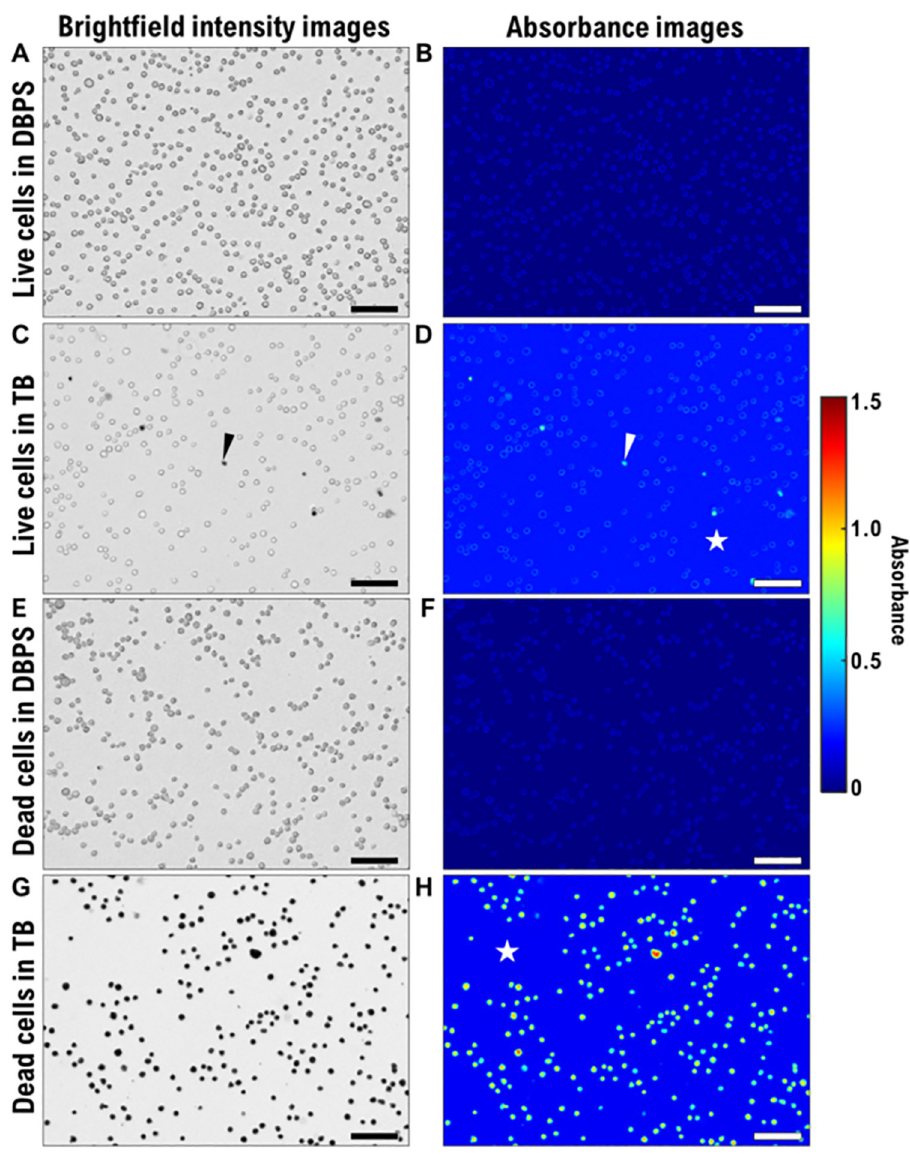
Fig 5. Brightfield intensity images and corresponding absorbance images of four Jurkat cell treatments. (A,B) LD: Live cells in Dulbecco’s phosphate-buffered saline (DPBS) solution; (C,D) LT: Live cells in trypan blue (TB) solution mixed with DPBS at a 1:4 (TB:DPBS) ratio; (E,F) DD: Dead cells in DPBS; (G,H) DT: Dead cells in TB solution mixed with DPBS at a 1:4 ratio (TB:DPBS). Dead cells were produced using the heat-shock cell killing method. Arrowheads in panels C and D indicate a dead cell in the LT sample. The stars in panels D and H indicate the medium which contains TB solution mixed with DPBS at a 1:4 ratio (TB:DPBS) and absorbs light giving it a lighter shade of blue (higher absorbance value as compared to panels B and F). Scale bars: 100 μ